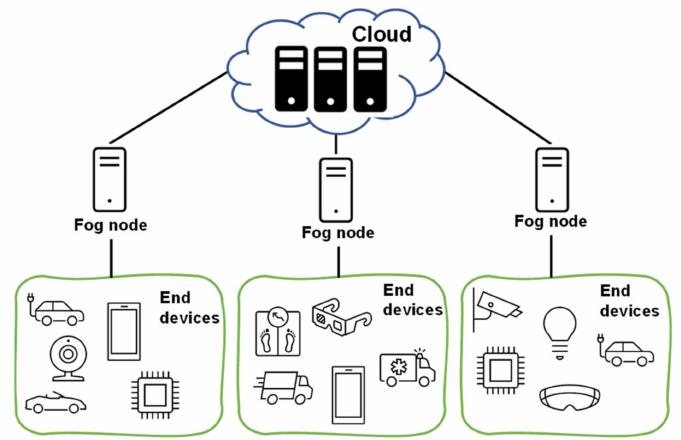
Figure 1. Fog computing